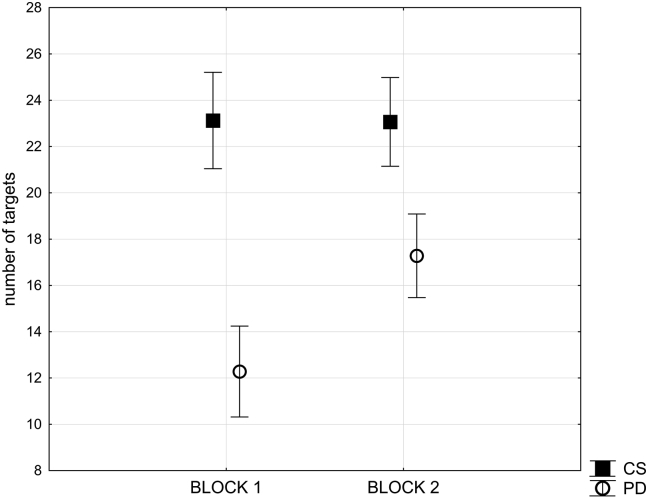
Effect of PD pathology on overall performance. This figure illustrates the mean number of targets identified for block one and block two of the experimental task compared across the patients with PD and the matched control group (CS). Bars represent standard error of the mean.